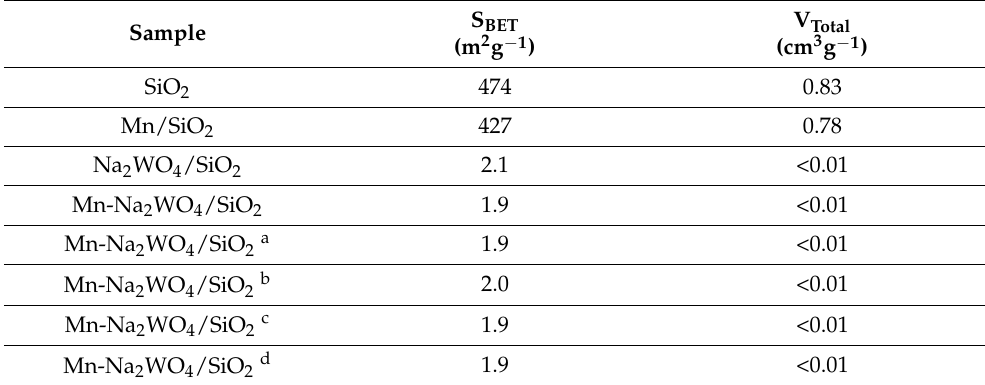
Table 1. Porosity and phase composition of fresh and used catalysts a .